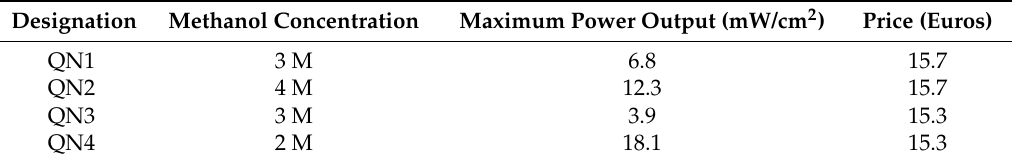
Table 2. Maximum power output corresponding to the better methanol concentration of each MEA tested and respective